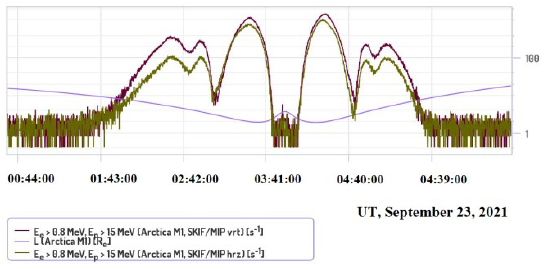
Fig. 4. Space-time profile of the ERB ( E e > 0.8 МeV, E p > 15МeV on the Арктика-М1 SC orbit 23.05.2021 in 00-06 UT.